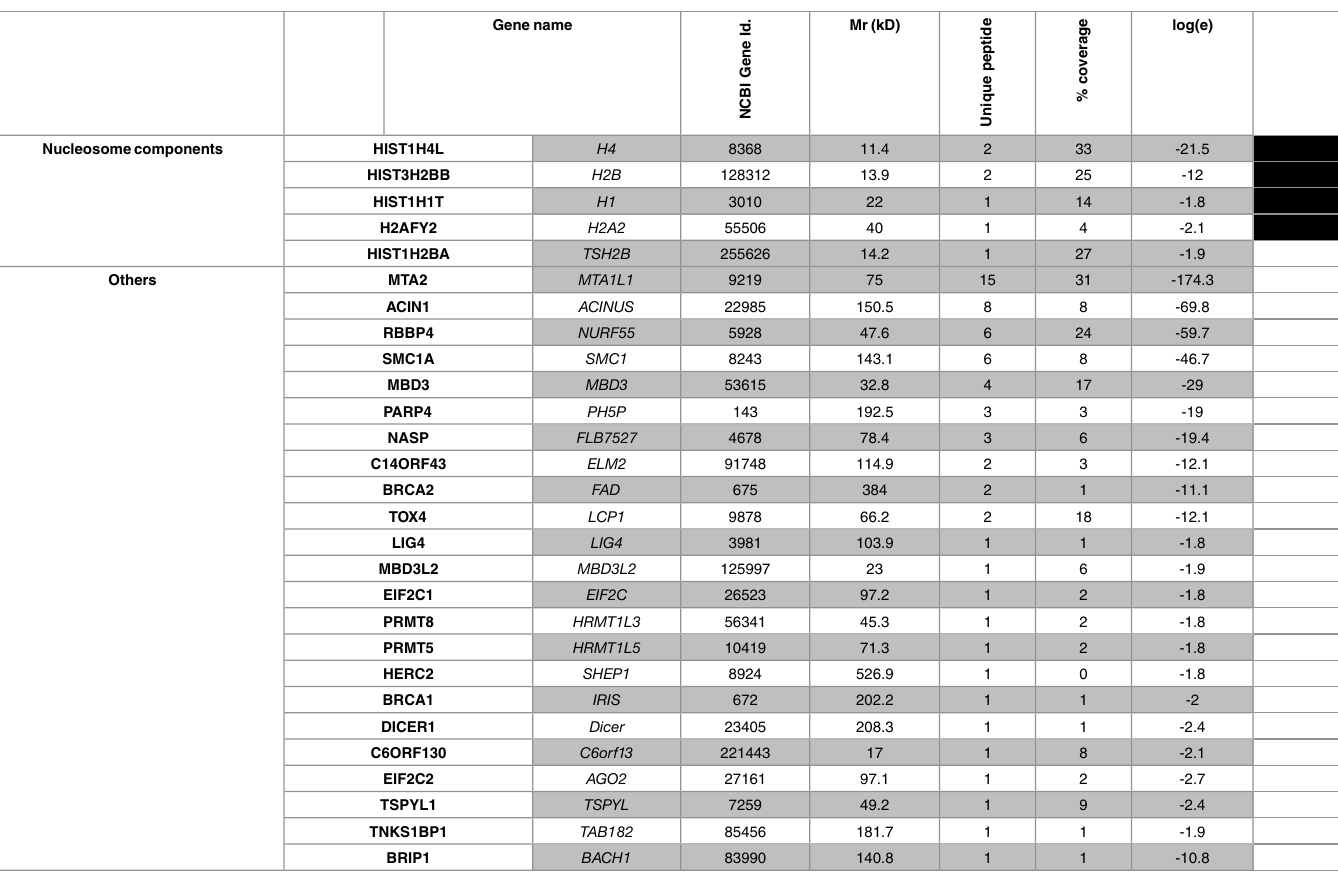
only when using the spliceosome-fractions(Figs 1D, lanes 4 & 5 and S1E, lanes 3 & 4). This indi- cated that these factors were physically together with the U2 snRNP only in the context of an assembled spliceosome. The Polycomb group protein PHC1 that was present in both the H com- plex- and spliceosome-fractionsbut not detected in the mass spectrometrydata, was not co- immunoprecipitated with FV -U2-B” and is shown as a negative control (S1E). 5 As will be further discussed below, the chromatin factors associated with FV -U2-B” were 5 enriched in subunits of chromatin remodeling complexes such as SWI/SNF, but included also readers and writers of histone modifications, and rather surprisingly histones. Altogether, these data showed that U2-snRNPs incorporated into splicing complexes assem- bled onto pre-mRNAs during or immediately after their transcription, are physically associated with chromatin